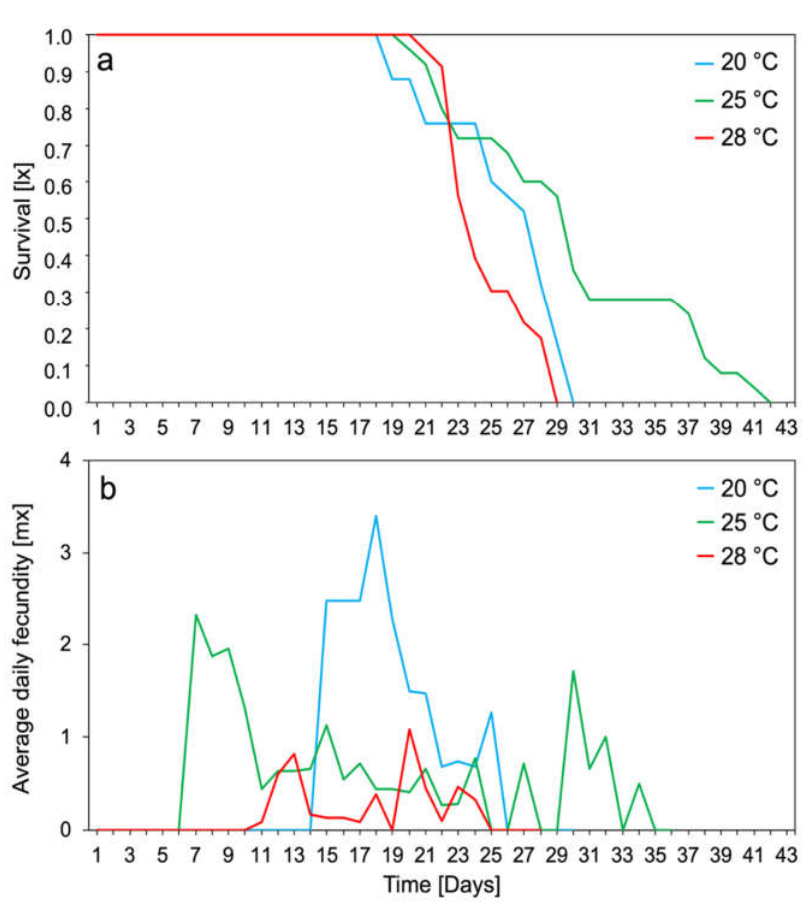
Figure 2. Survival rates ( a ) and daily fecundity ( b ) of apterous females Macrosiphum rosae at different temperatures ( n = 100 at each temperature: 20, 25, and 28 °C).